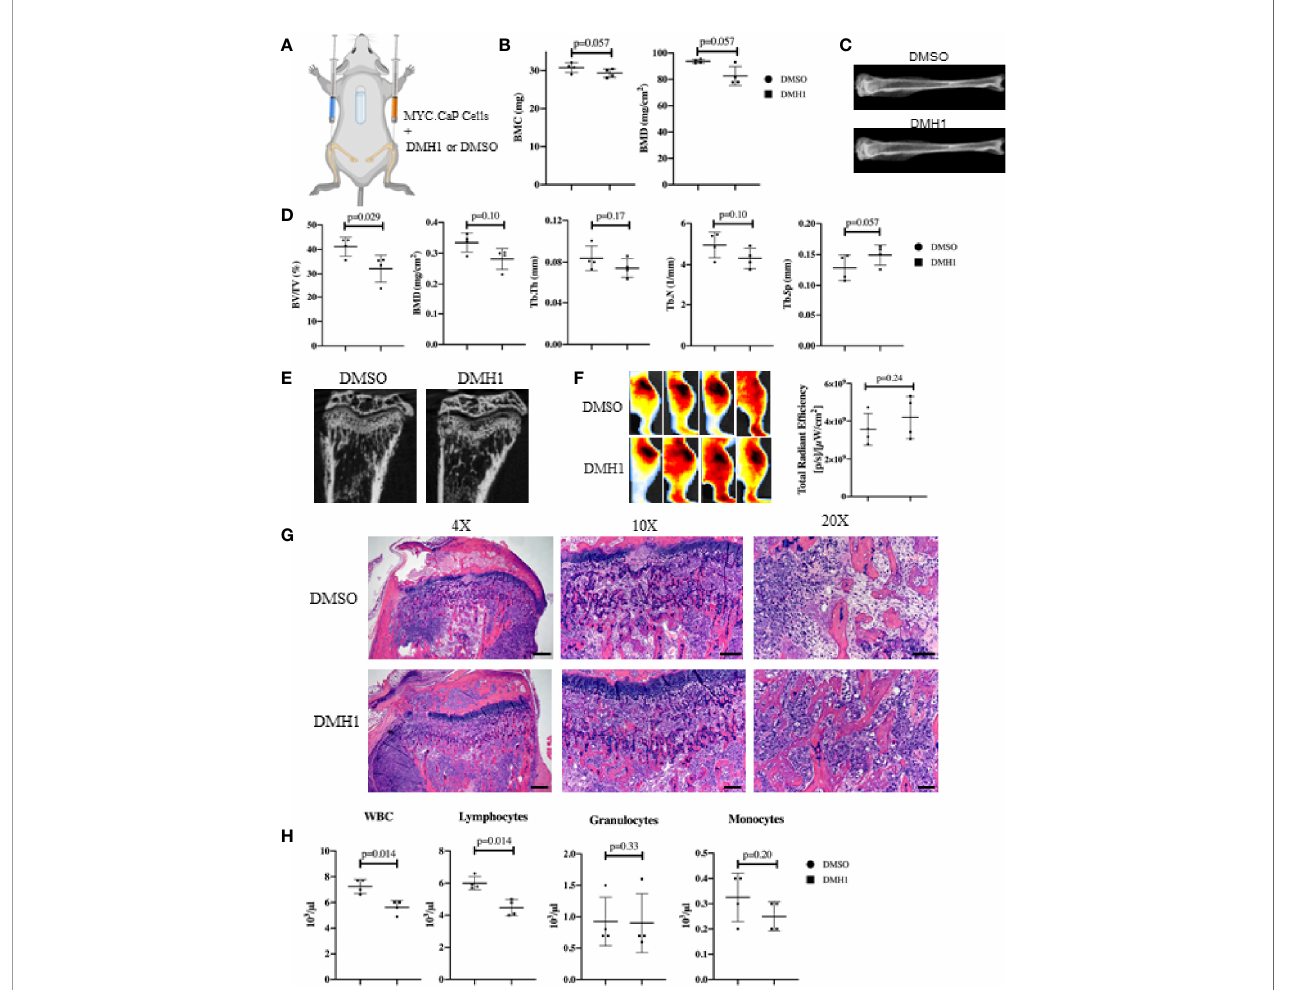
FIGURE 4 | BMP Inhibition of Established Mouse Prostate Cancer Cells Does Not Reduce Tumor Burden. (A) Eight male 8-week-old FVBn mice received 100,000 MYC-CaP cells via tibial injection. All mice received a PBS injection of 10µl in the right tibia and 10µl of MYC-CaP cells injected into the left tibia. 6 days post tibial injections, mice received an IP injection of zoledronic acid and a subcutaneous 4-week osmotic pump implant containing DMSO (n=4) or DMH1 (n=4). Mice were euthanized at expiration of the pumps. (B) Faxitron BMC and BMD measurements derived from selecting an ROI encompassing the whole tibia. (C) Representative tibial images from DXA imaging. (D) µCT bone health quantitation data from the tibia. (E) Representative µCT tibial images of tumor bearing left tibia imaged ex vivo . (F) IVIS fl uorescence detection using 750 2-DG mice were intravenously injected 5 hours before data acquisition at 28 days post implantation of the osmotic pump. Image shows ROIs of the tumor bearing left tibia. The graph indicates total radiant ef fi ciency of the ROI. (G) Representative H&E histology slides. Scale bars for 4X, 10X and 20X are 200µm, 100µm and 50µm respectively. (H) Complete Blood Count (CBC) from peripheral blood at time of euthanasia. Statistical signi fi cance was determined using a Mann-Whitney U test and error bars indicate